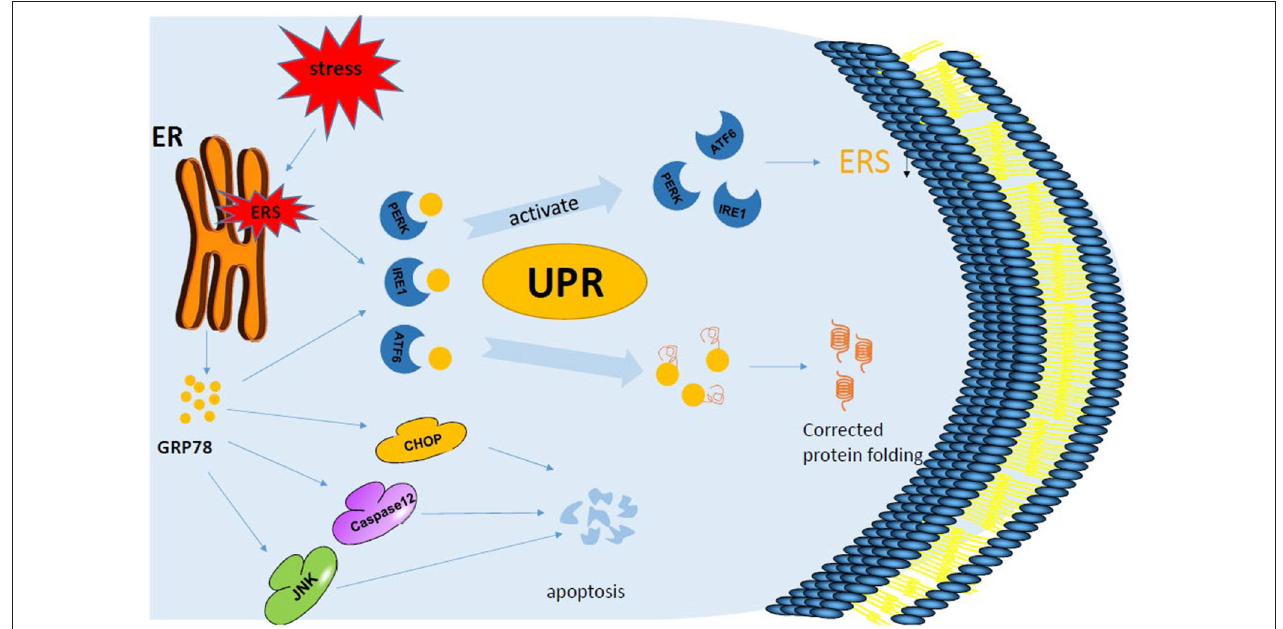
FIGURE 2 | GRP78 and endoplasmic reticulum stress. When a cell is under the influence of foreign factors, the endoplasmic reticulum is stressed, leading to the appearance of unfolded proteins or misfolded proteins inside the cell, which accumulates in the cell. At this time, three specific signaling pathways, PERK, IRE1, and ATF6, trigger the unfolded protein response. PERK, IRE1, ATF6, and GRP78 are activated from the binding state to the detached state. GRP78 binds to unfolded proteins or misfolded proteins to correct protein folding, while PERK and other physiological reactions reduce protein synthesis after a series of phosphorylation. In addition, the expression of GRP78 is up-regulated when ERS occurred, and the pro-apoptotic pathways caspase 12, JNK, and CHOP are activated. When UPR exceeds a specified limit, it also induces apoptosis through the caspase 12